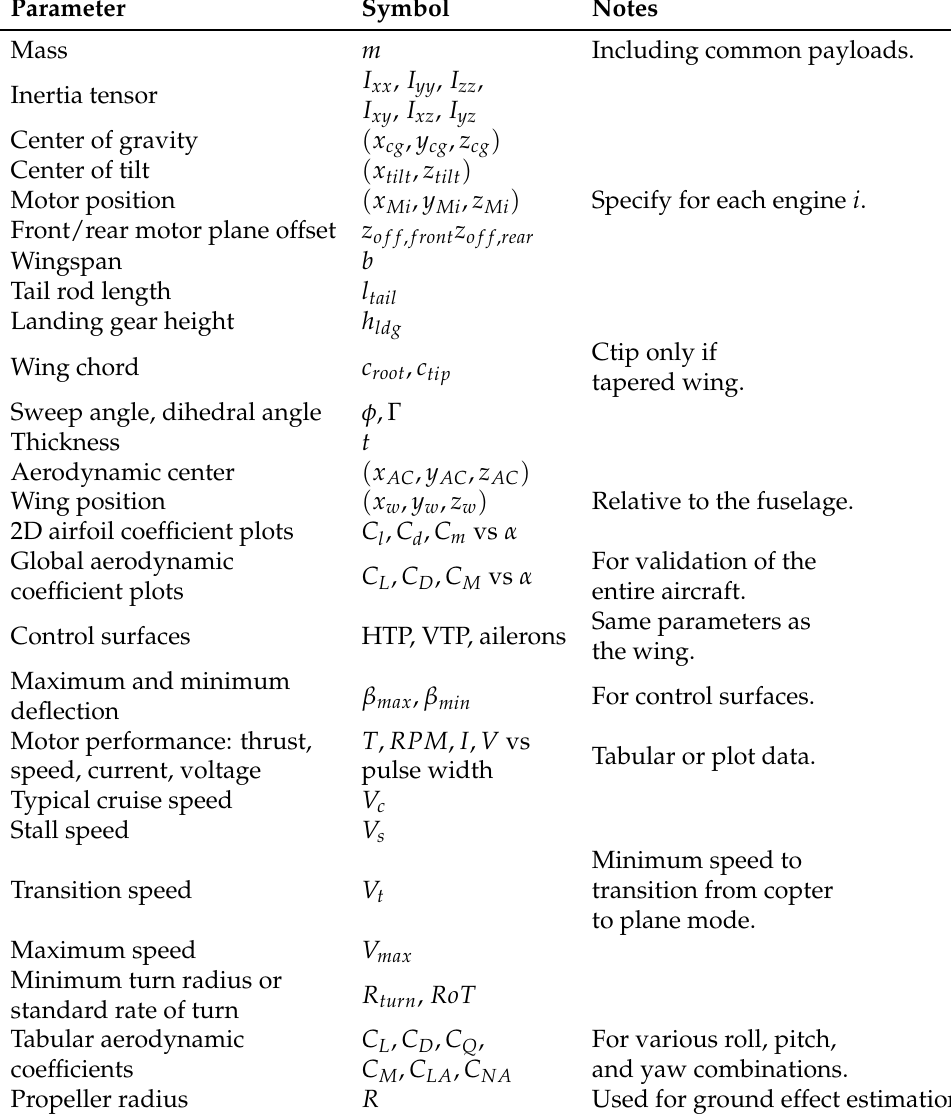
Table 1. Summary of the VTOL UAV simulator parameters required for